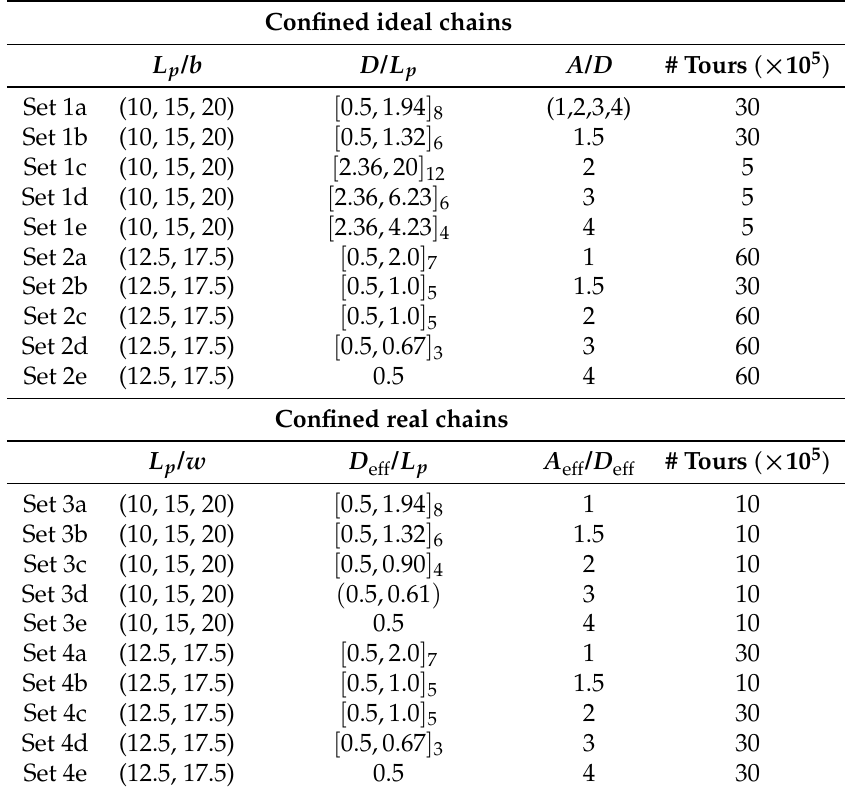
Table 1. Summary of parameters used in pruned-enriched Rosenbluth method (PERM) simulations. The quantity [ a , b ] n in the table indicates a sequence of n values logarithmically spaced between a and b , including a and b . The maximum molecular weight in each simulation was set based on the values of L p , w , D and A so as to reach the limit where the theromdynamic quantities are extensive in chain length. Depending on these parameters, the maximum molecular weight in our simulations ranges from 10,000 to 100,000